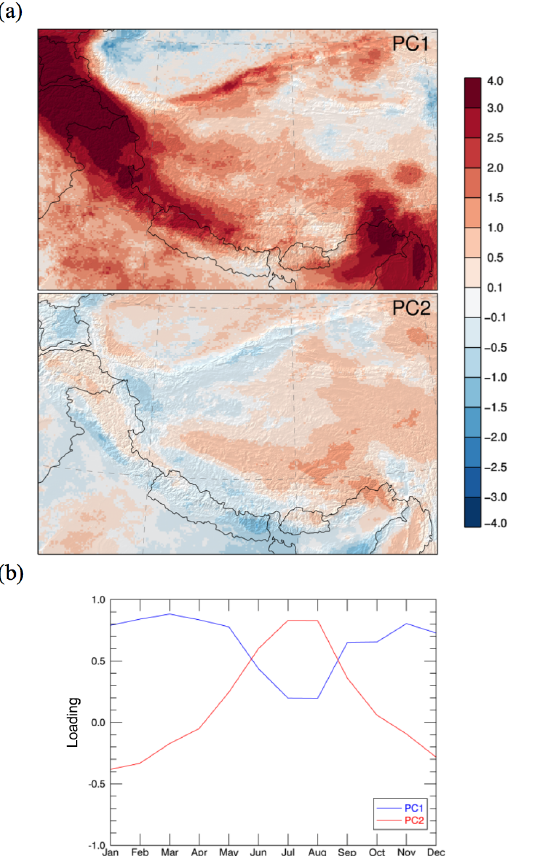
Figure 10. Scores of first two principal components PC1 and PC2 for the correlation between vertical wind speed at 300hPa (W300) and precipitation (a) (positive values are denoted in red, while neg- ative values are denoted in blue) and the monthly loadings (b) for both PCs.